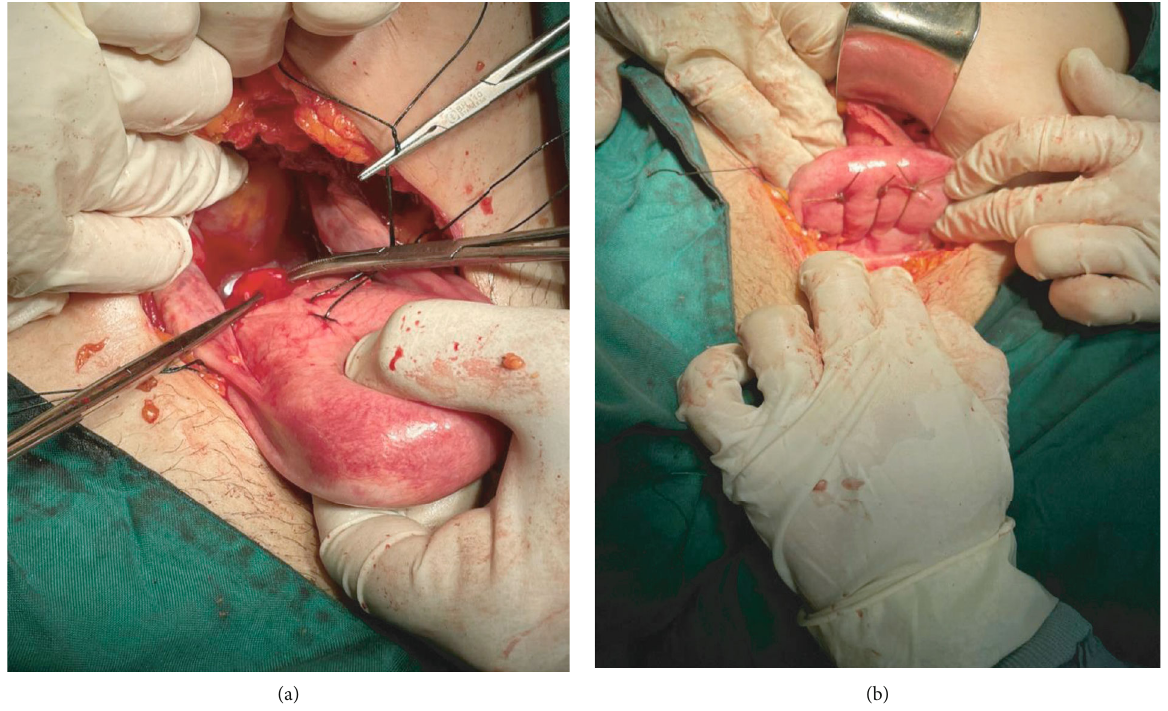
Figure 3: The uterus was returned to the pelvic cavity (a) and then uterine suspension to the round ligament (b).